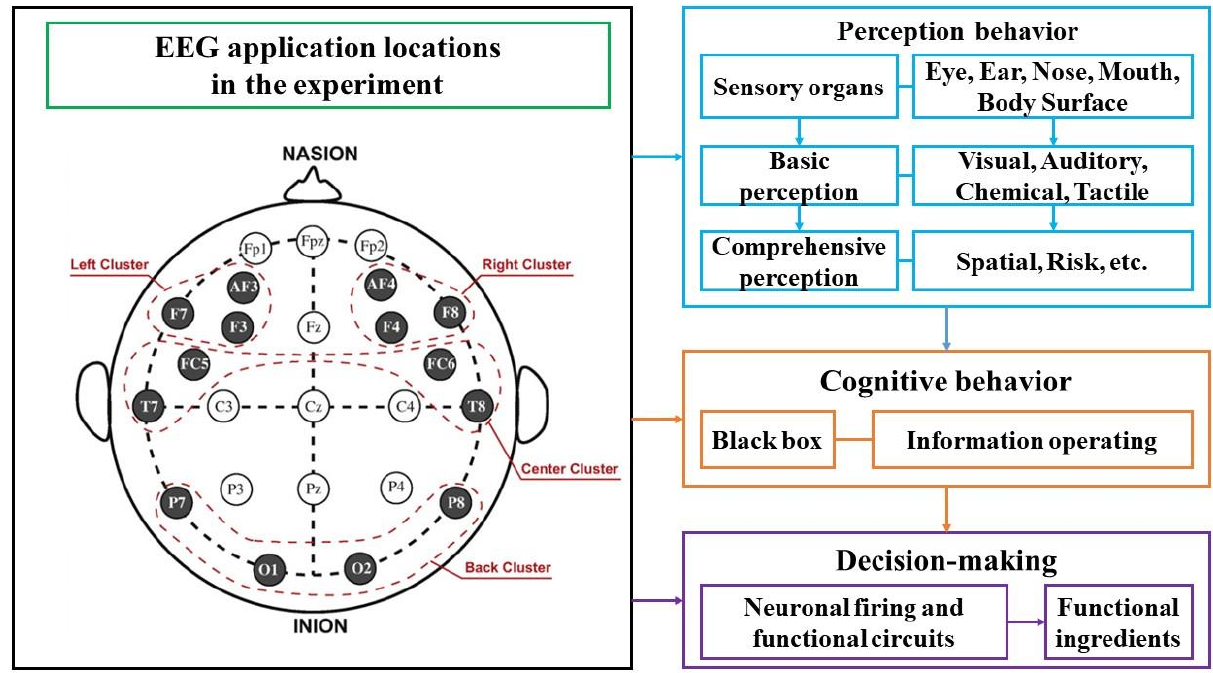
Figure 2. Neuropsychological mechanism of behavior. The electrode lead system on the left is adapted from Wang et al. (2017), and the others are drawn by the authors.